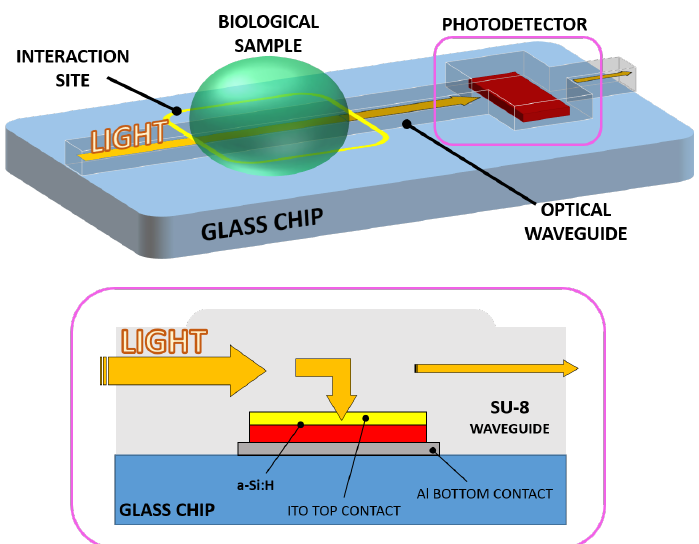
Figure 1. 3D sketch of the system ( top ) with a section of the waveguide-detector coupled site ( bottom